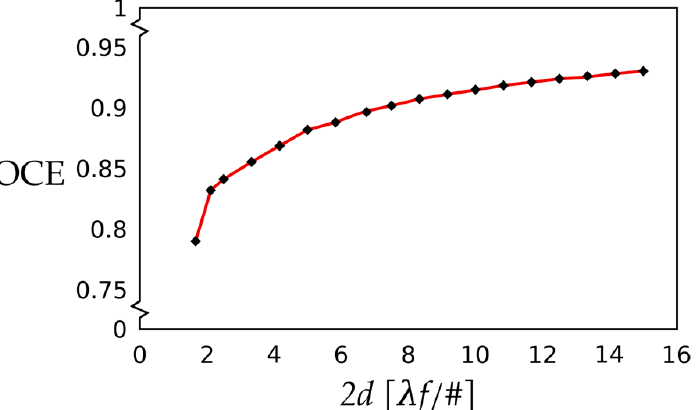
Figure 7. Optical centroid efficiency vs. detector pixel size in units of [ λ F/#] for a perfect optical system with a circular aperture, without a central obscuration.